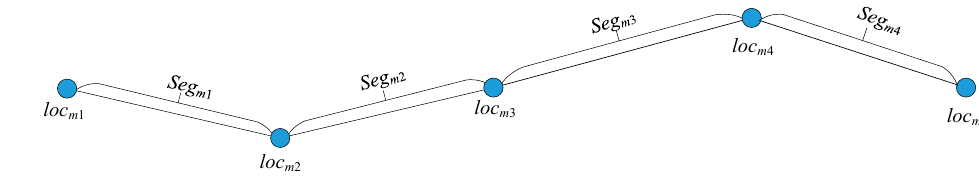
Figure 1. Trajectory segment example. Each point represents a location in the trajectory. There are four trajectory segments and five locations.